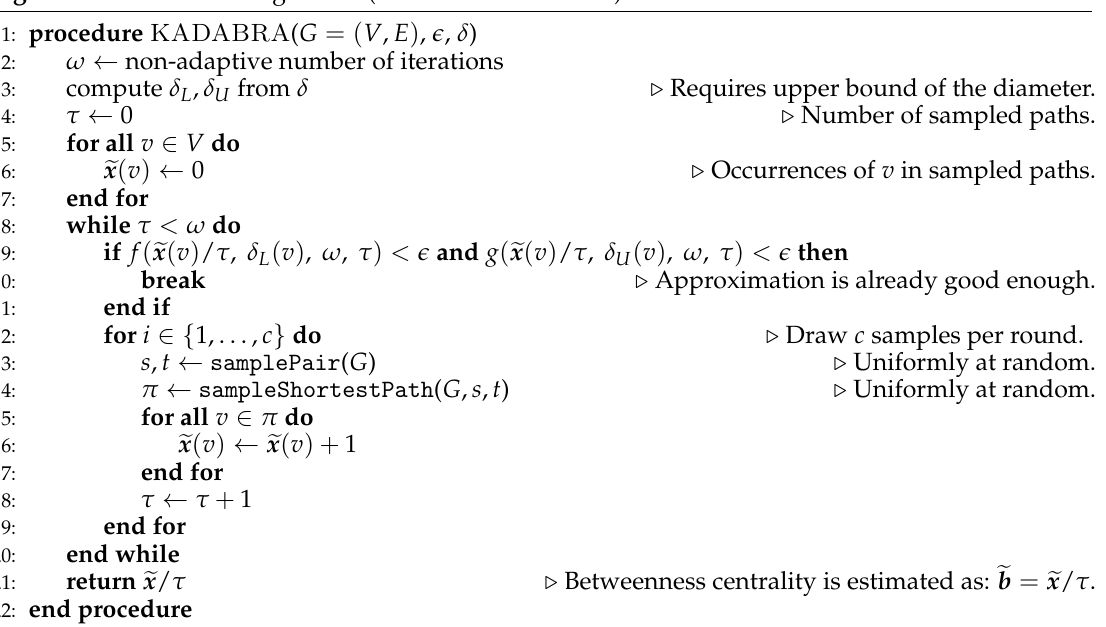
Algorithm 1 KADABRA algorithm (absolute error